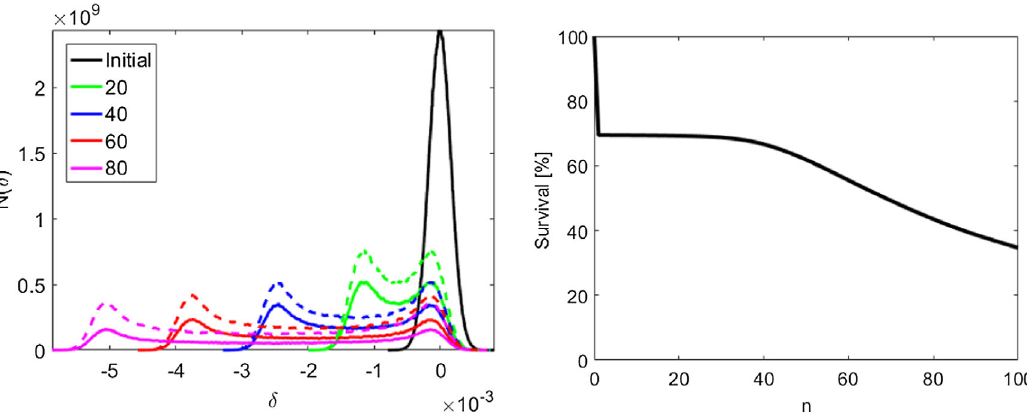
FIG. 18. Energy spectra with 1 nm (solid lines) and zero (dashed lines) transverse emittance normalized to the initial number of particles 10 6 (left) and particle survival rate